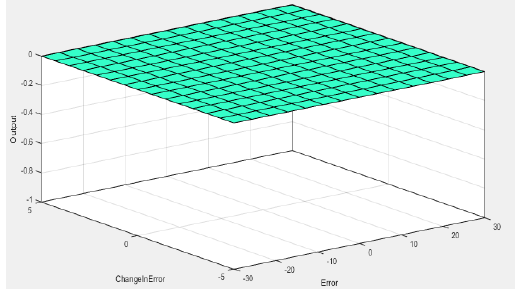
Fig.7: Input and output surface waveforms of fuzzy MPPT